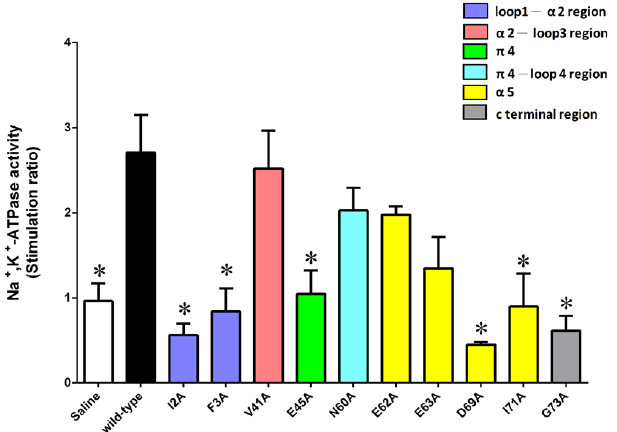
Figure 5. Determination of the functionally important residues of Sco-CHH-L for the Na+, K+- ATPase activity in posterior gills of the mud crab Scylla olivacea . The posterior gill (gill 6) were dissected out and received perfusion of saline, Sco-CHH-L, or an alanine-substituted Sco-CHH-L mutant at 125.0 pM preparation. Data are means ± SEM and expressed as stimulation ratio. n = 5 for each point. The asterisk (*) indicates significantly different from the Sco-CHH-L group at 5% level.